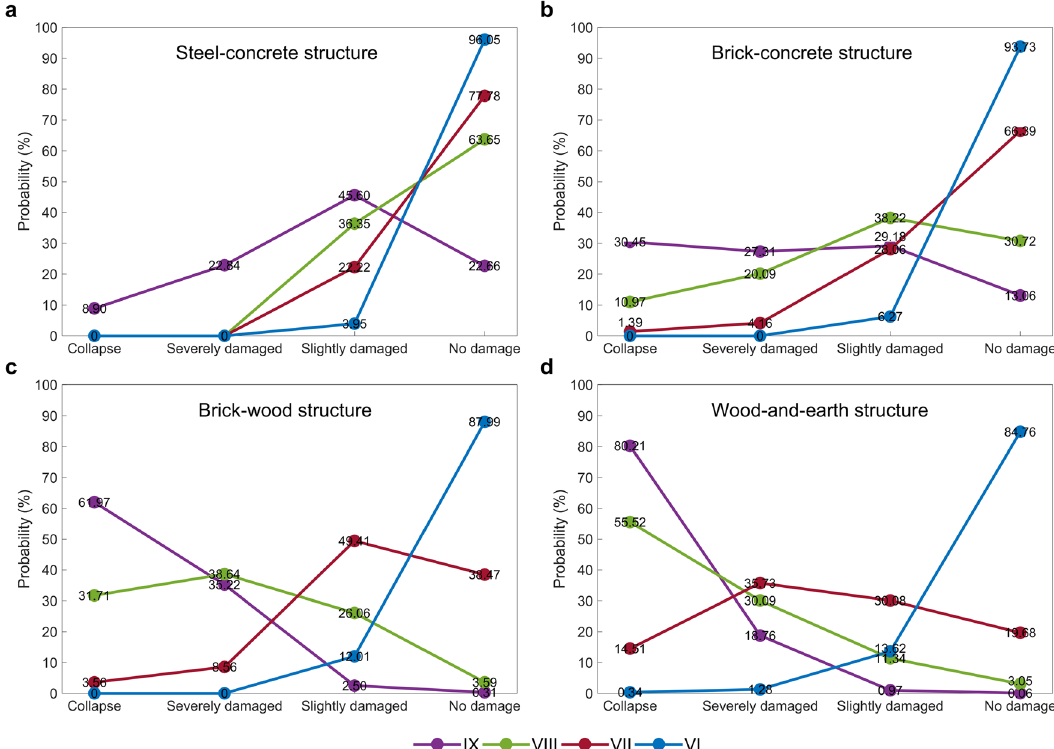
Fig. 3 The collapse and damage rates of buildings for different structure types in different seismic intensity zoning. a Steel-concrete structure. b Brick- concrete structure. c Brick-wood structure. d Wood-and-earth structure. The numerals IX, VIII, VII, and VI represent seismic intensity, and the vertical axis represents the probability of occurrence under different damage